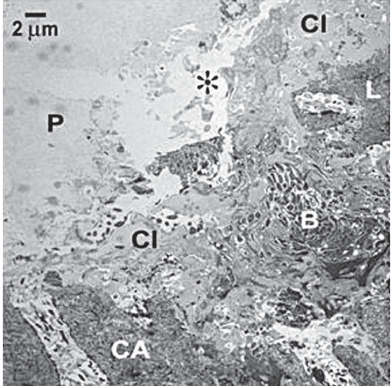
FIGURE 5 - Bonding of the ABF system to caries-infected dentin showing the variability of the pathological bonding substrate. Stained, undemineralized section. In its simplest form, the hybrid layer(between arrows) consisted of a thin layer of carious-infected dentin (CI) that contained colonized bacteria (arrowhead) that was connected with a layer or caries-affected dentin(U) that was highly porous. The dentinal tubules were completely obliterated with minerals that accounted for the reduction in the permeability in carious dentin.